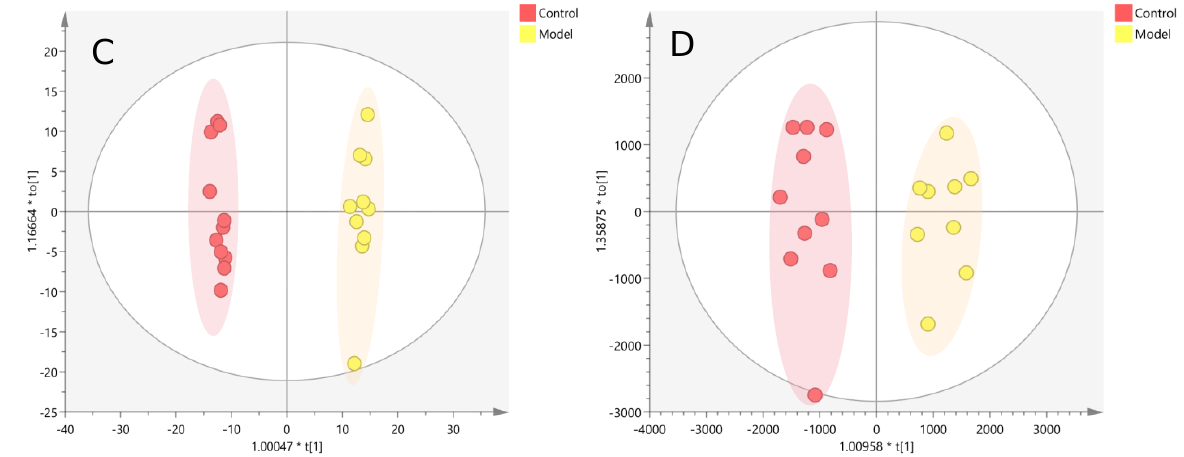
Figure 5. Metabolic profile analysis of the serum of the T2D model in db/db mice (( A ). NEG, PCA; ( B ). POS, PCA; ( C ). NEG, OPLS-DA; ( D ). POS, OPLS-DA).